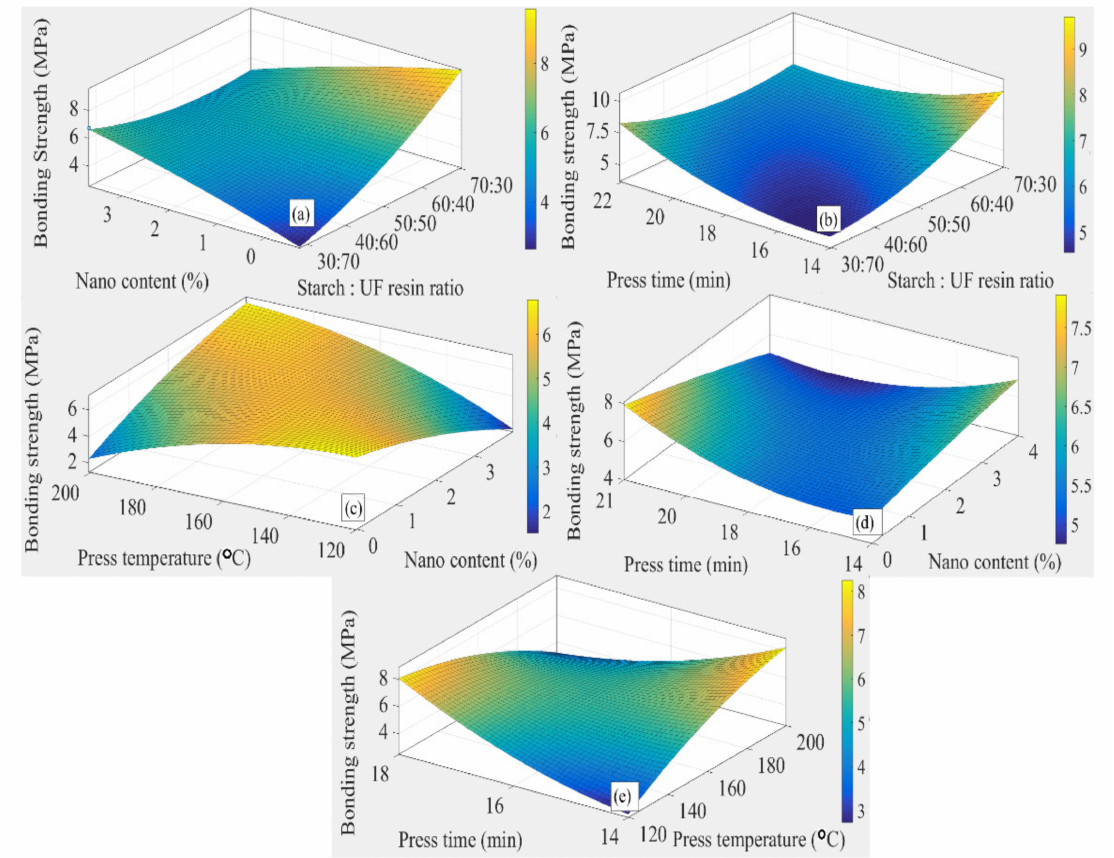
Figure 8. Interactive effect of independent variables on bonding strength: MSt. × NC ( a ), MSt. × PTim ( b ), NC × PTem ( c ), NC × PTim ( d ) and PTem × PTim ( e